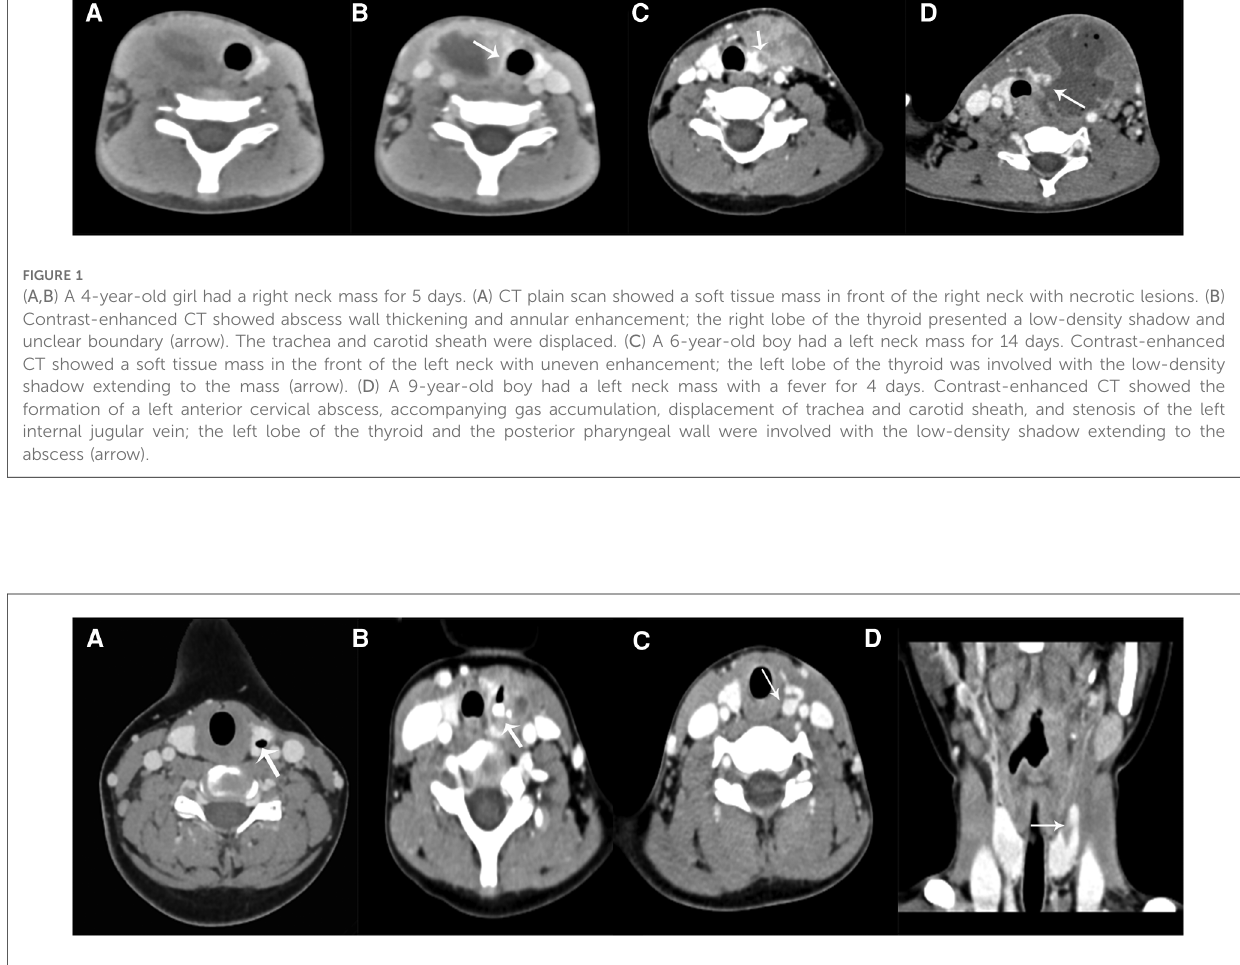
FIGURE 2 ( A ) A 12-year-old boy had a left neck mass for 8 years. Contrast-enhanced CT showed the local gas accumulation in the left lobe of the thyroid gland (arrow). ( B ) A 4-year-old boy had a recurrent infection in the left neck for more than 20 days. The thyroid showed local gas accumulation and high- density contrast medium residue (arrow); adjacent soft tissue swelling showed a low-density shadow. ( C ) (axial) and ( D ) (coronal). A 7-year-old boy had a left neck mass for 8 months. The contrast-enhanced CT showed a linear low-density shadow in the upper pole of the left lobe of the thyroid gland (arrow).